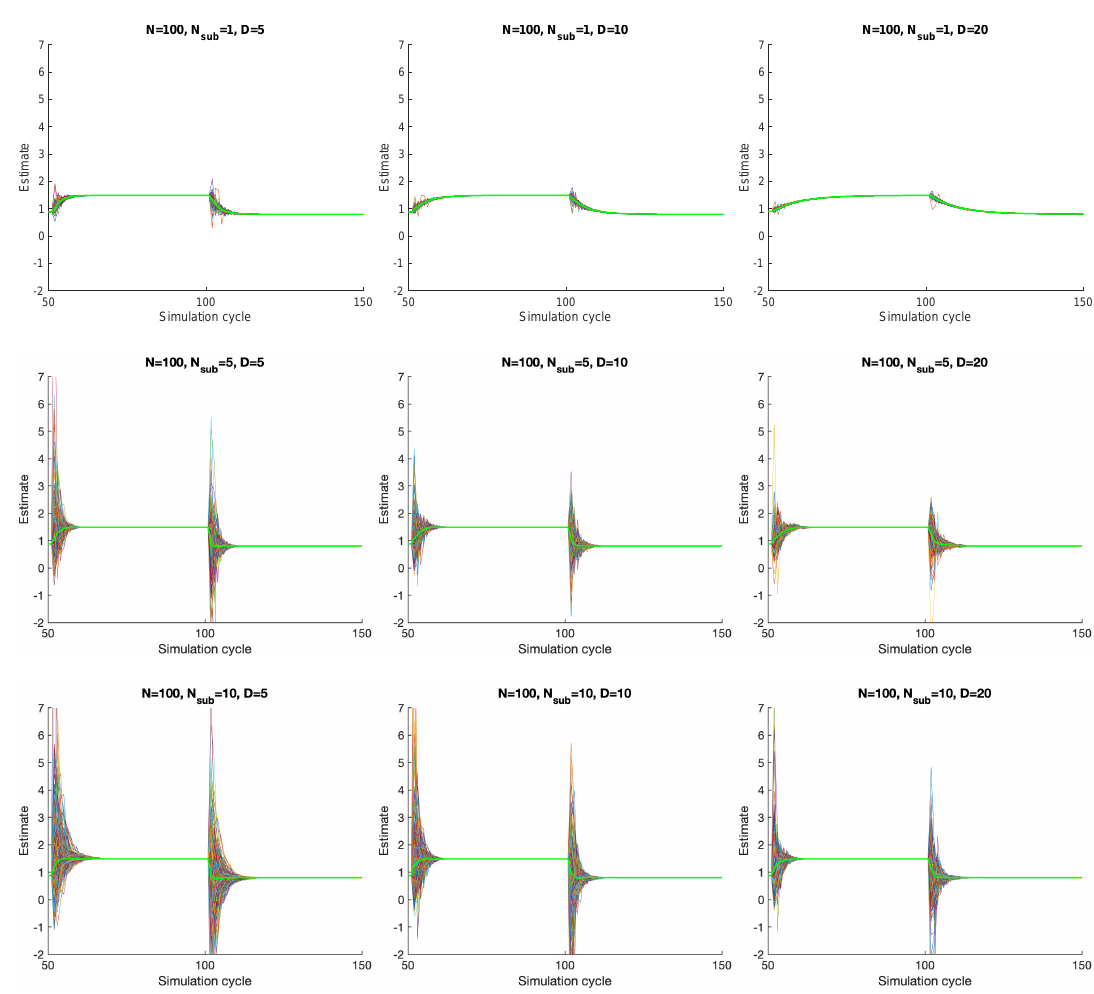
Figure 5. Convergence of the PP-Overgrid algorithm with N = 100 nodes, subnodes n = { 1,5,10 } and graph degree D = { 5,10,20 }